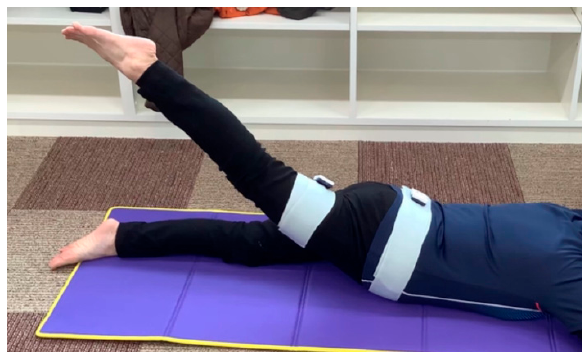
Figure 1. Measurement of pelvic and femoral movement during prone hip extension (PHE) using an inertial sensor.